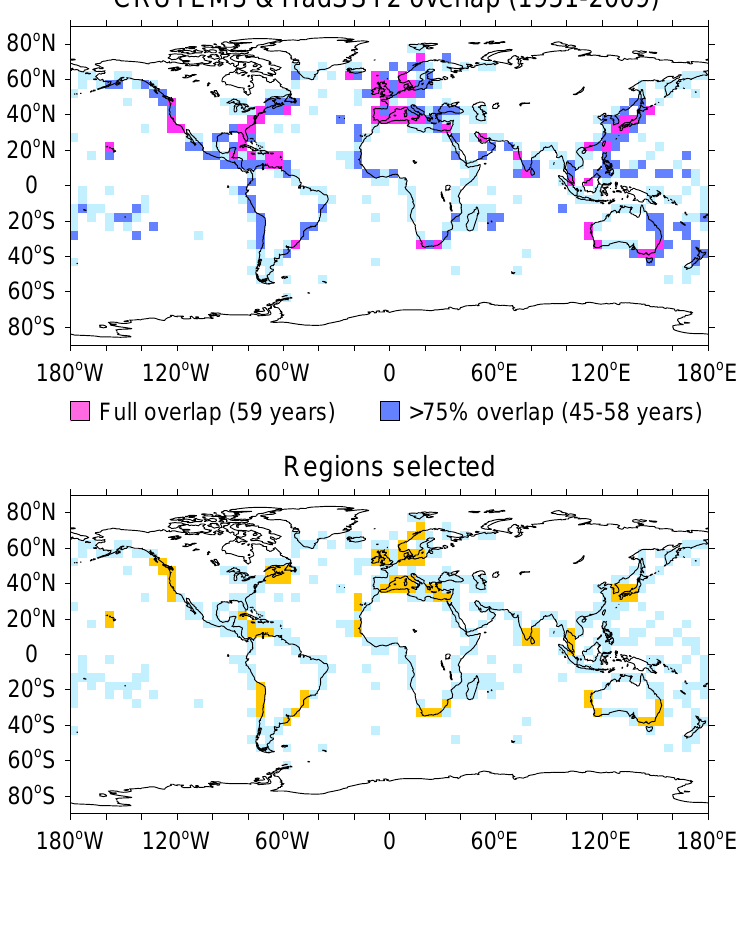
Figure 1. (Top) Coastal and island grid boxes with complete (magenta), 75–99% (deep blue) and <75% (light blue) coverage of overlapping data. (Bottom) as Top, but